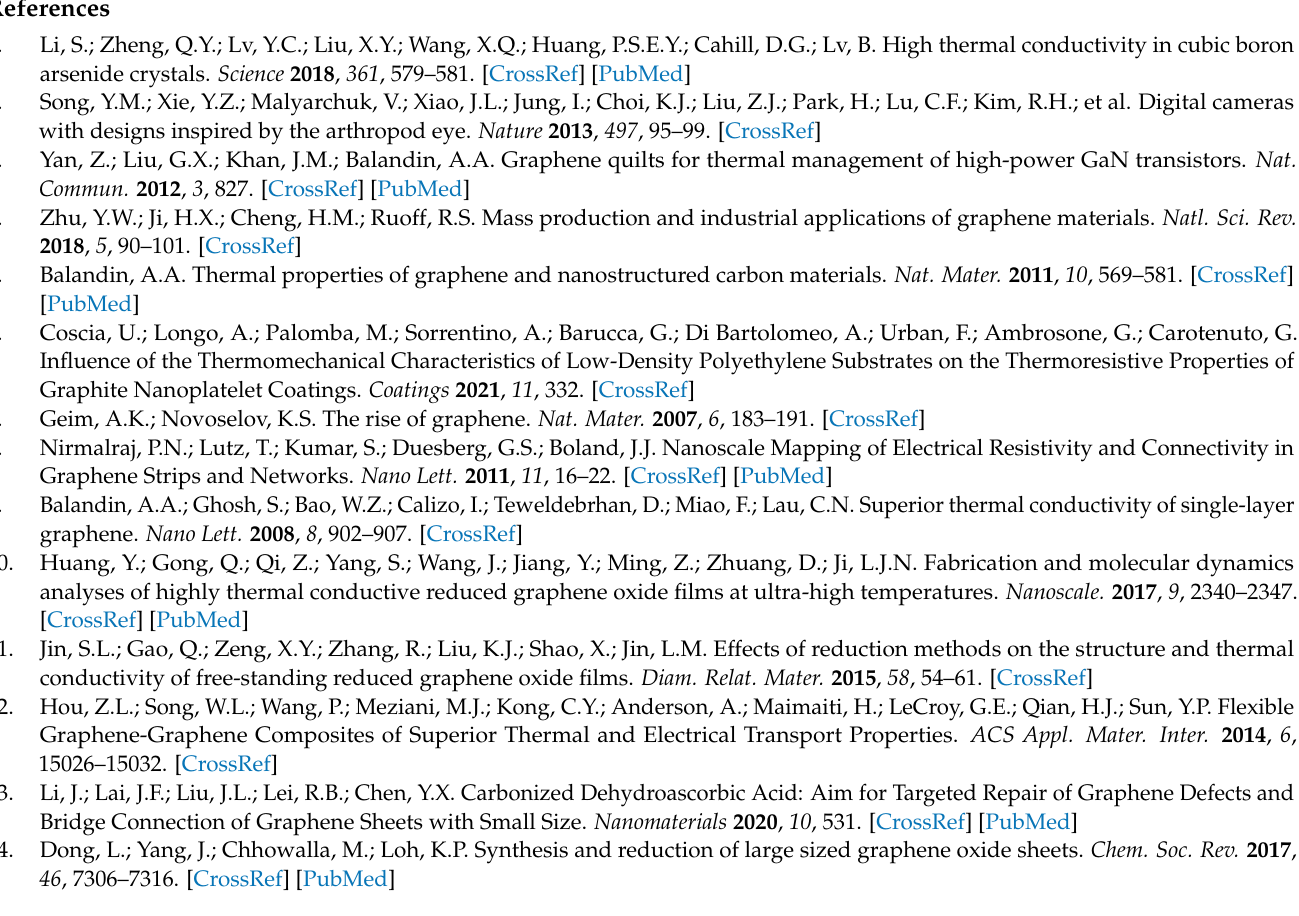
Figure S3: GO dispersions of different concentrations, Figure S4: Bending cycle test device, Figure S5: The XRD of original graphite, Figure S6: Heat generating scene of electronic equipment, Table S1: The thickness and the bulk density of samples in the LFA measurement, Table S2: The thickness and the bulk density of samples in the LFA